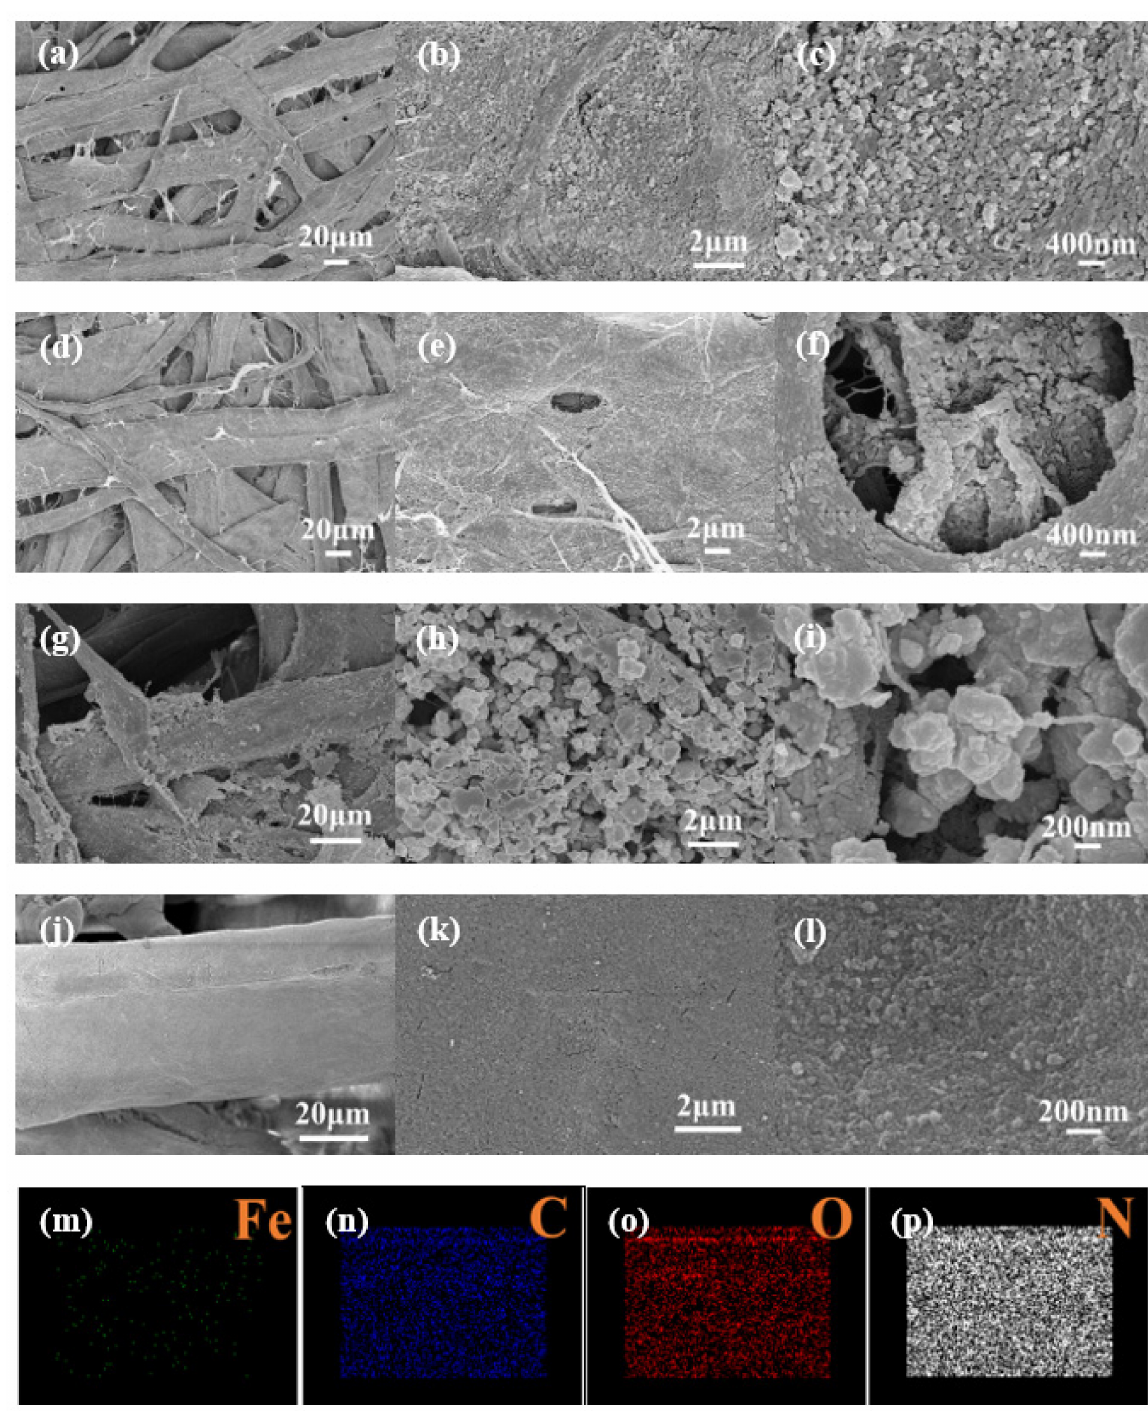
Figure 3. SEM images of PANI@CelF ( a – c ), DPANI@CelF ( d – f ), MIL-100(Fe)@CelF ( g – i ), MIL-100(Fe)@DPANI@CelF ( j – l ); EDS images of MIL-100(Fe)@DPANI@CelF ( m – p